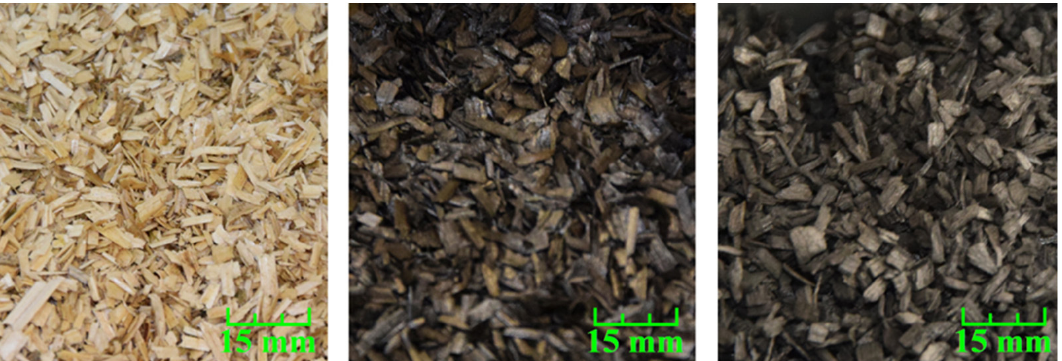
Figure 1. Visual appearance of the sample (left—raw material, middle—residue after the pyrolysis up to 450 °C, and right—residue after the pyrolysis up to 750 °C). Table 1. The parameters of the tested material based on proximate and ultimate analysis. Parameter